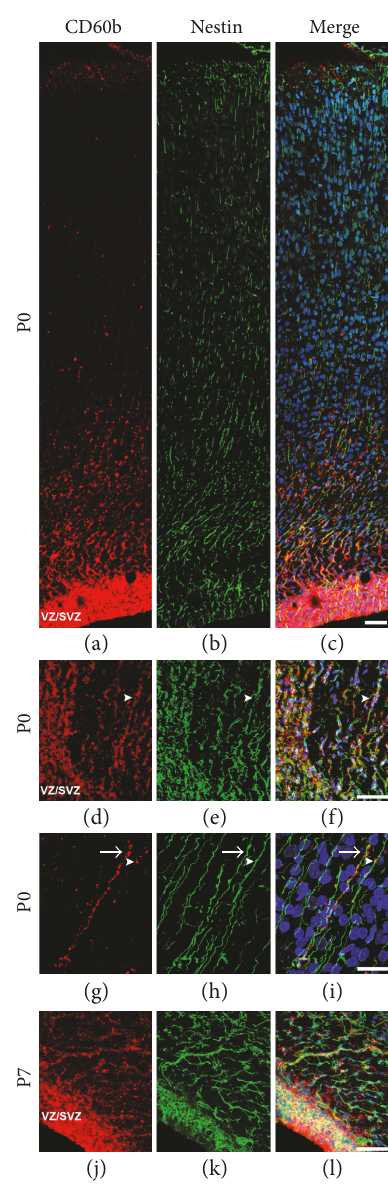
Figure 2: CD60b expression in radial glial cells in the newborn brain. Confocal images of early postnatal forebrain cryosections showing the expression of CD60b (in red) and of the intermediate fi lament nestin (in green) in the developing cerebral cortex of P0 (a – i) and P7 (j – l) rats. The photomontage in (a – c) shows the pattern of expression of CD60b in the P0 brain. Note that the ganglioside is expressed in nestin-positive cells in the VZ/SVZ and in the proximal part of radial glial cell processes, as shown in high magni fi cation images of P0 (d – f) and P7 brains (arrowheads (j – l)). Arrowhead in (d – f) shows an example of a radial glial cell process expressing both nestin and CD60b. In the occipital cerebral cortex, CD60b is still expressed in the distal part of a few radial glial cell processes (g – i) with 2 distinct patterns: while several processes have a punctacte expression of the ganglioside (arrowheads in (g – i)), we also observed a strong and continuous expression along other few processes (arrow in (g – i)). Scale bar: 50 μ m (a – f, j – l) or 20 μ m (g – i). Nuclear staining with TO-PRO-3 in blue (c, f, i, and l). VZ/SVZ: ventricular zone/subventricular